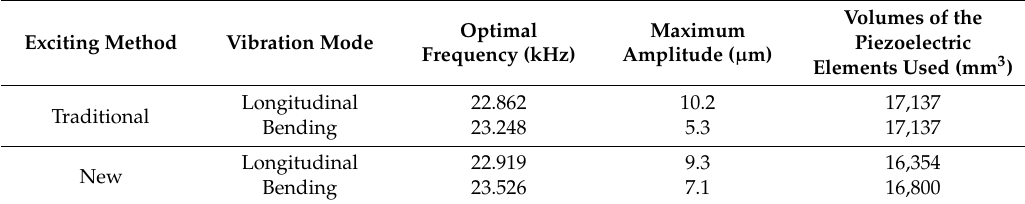
Table 2. The vibration analysis results under different exciting methods.